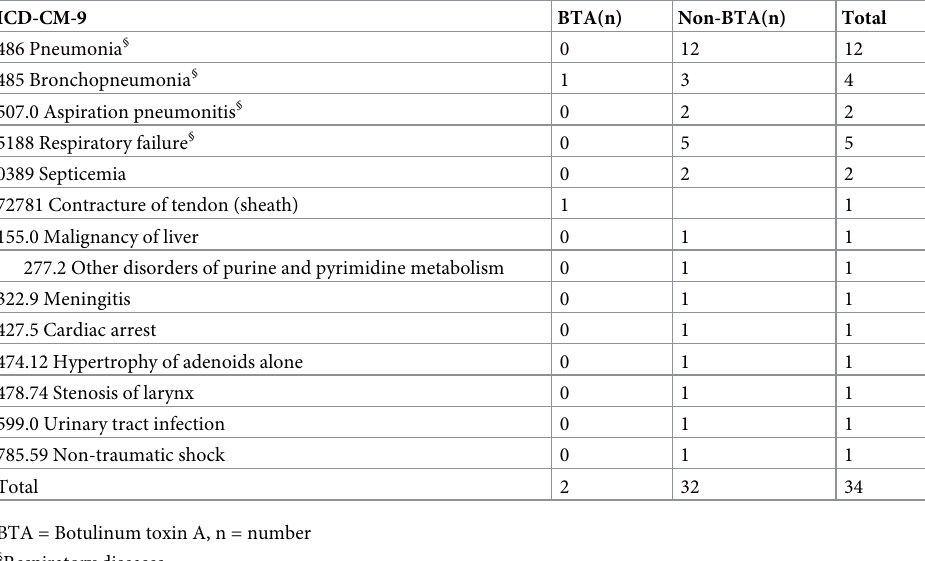
Table 5. Distribution of the causes of death in both